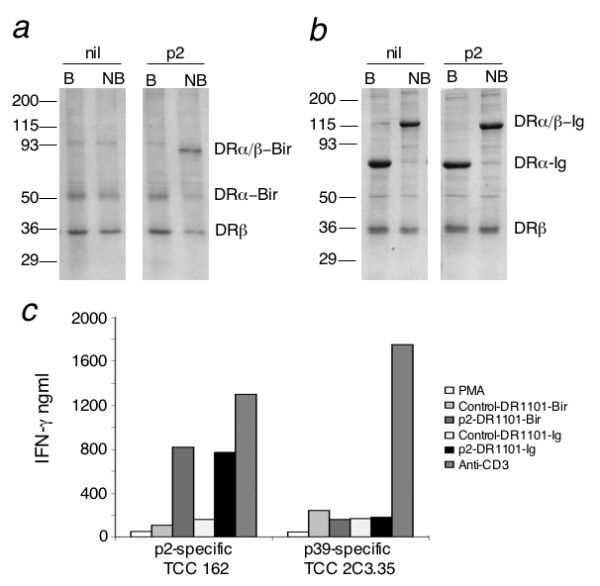
HLA-DR*1101-Ig and HLA-DR*1101-Bir molecules can be loaded with synthetic peptides. Purified soluble HLA-DR*1101-Ig and HLA-DR*1101-Bir molecules were loaded with equal amount of p2 peptide. Stability of the peptide-loaded HLA-DR*1101 αβ heterodimers was determined by running complexes in reducing condition on SDS gels without boiling, or by testing their capacity to elicit IFN-γ production in specific CD4+ T cell clones. (a) SDS-resistance assay of HLA-DR*1101-Bir molecules. Indicated are the protein bands corresponding to the migration of either the HLA-DR*1101-Bir αβ heterodimer, or the single HLA-DRα-Bir or HLA-DR*1101β chains. Lane nil: unloaded HLA-DR*1101-Bir molecules. Lane p2: p2-loaded HLA-DR*1101-Bir molecules. (b) SDS-resistance assay of HLA-DR*1101-Ig molecules. Indicated are the protein bands corresponding to the migration of either the HLA-DR*1101-Ig αβ heterodimer, or the single HLA-DRα-Ig or HLA-DR*1101β chains. Lane nil and p2 are the same as per HLA-DR*1101-bir. (c) IFN-γ production by the p2-specific CD4+ T cell clone (TCC) 162 in response to p2-loaded HLA-DR*1101-Bir or HLA-DR*1101-Ig molecules, attached to plastic. The response of the MAGE-3 p39-specific CD4+ TCC 2C3.35 is shown as control. T cells were cultured in the presence of the indicated peptide-pulsed HLA-DR*1101 recombinant molecules, in the presence of a costimulatory dose of PMA. As control, T cells were cultured in the presence only of sub-optimal doses of PMA (PMA), or activated by plastic-bound anti-CD3 mAb (Anti-CD3). The release of IFN-γ in the culture supernatant was determined by ELISA 48 h later.